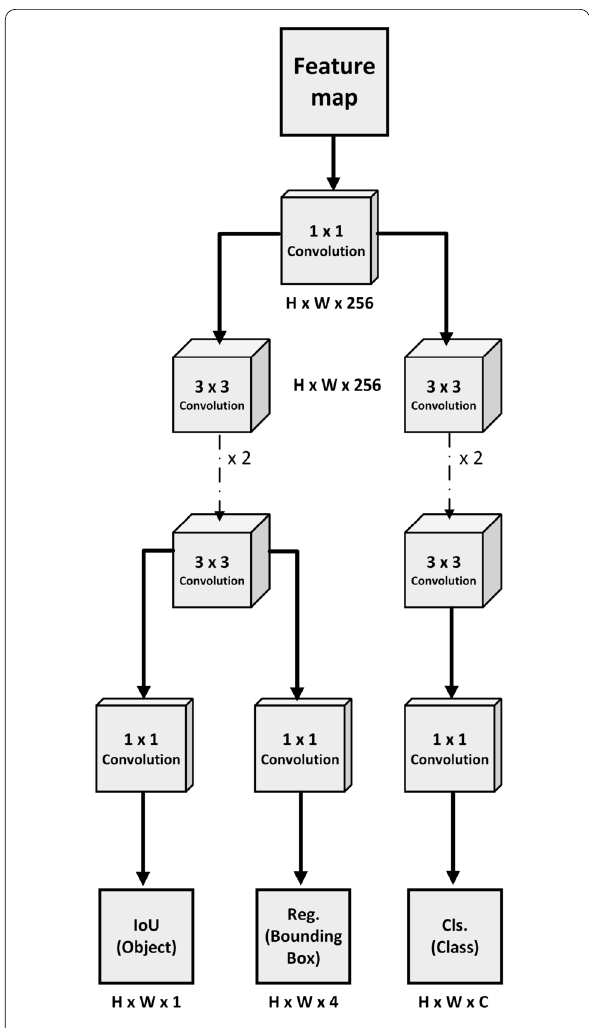
Figure 2 Schematic structure of YOLOX head